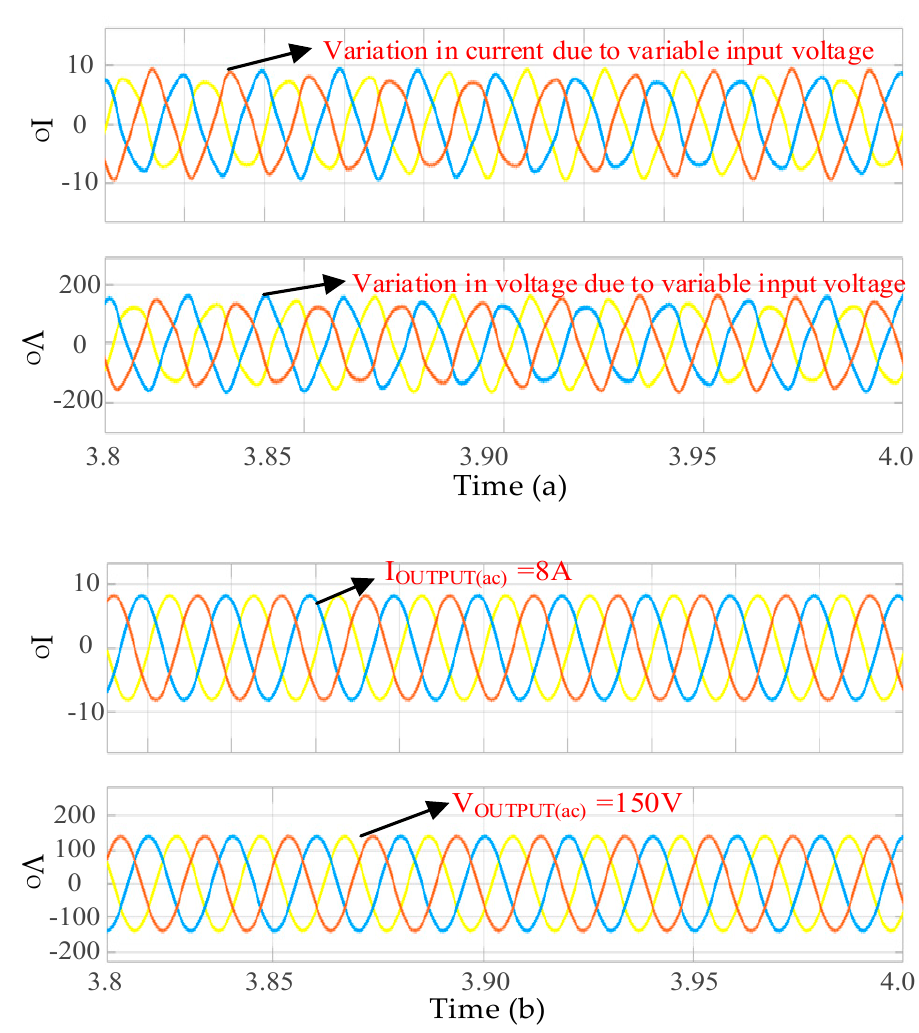
Figure 14. ( a ) The output voltage and current of the 3-phase inverter interfaced with the ZSC during the transient state, ( b ) the output voltage and current of 3-phase inverter interfaced with HS-SZSC during transient state.